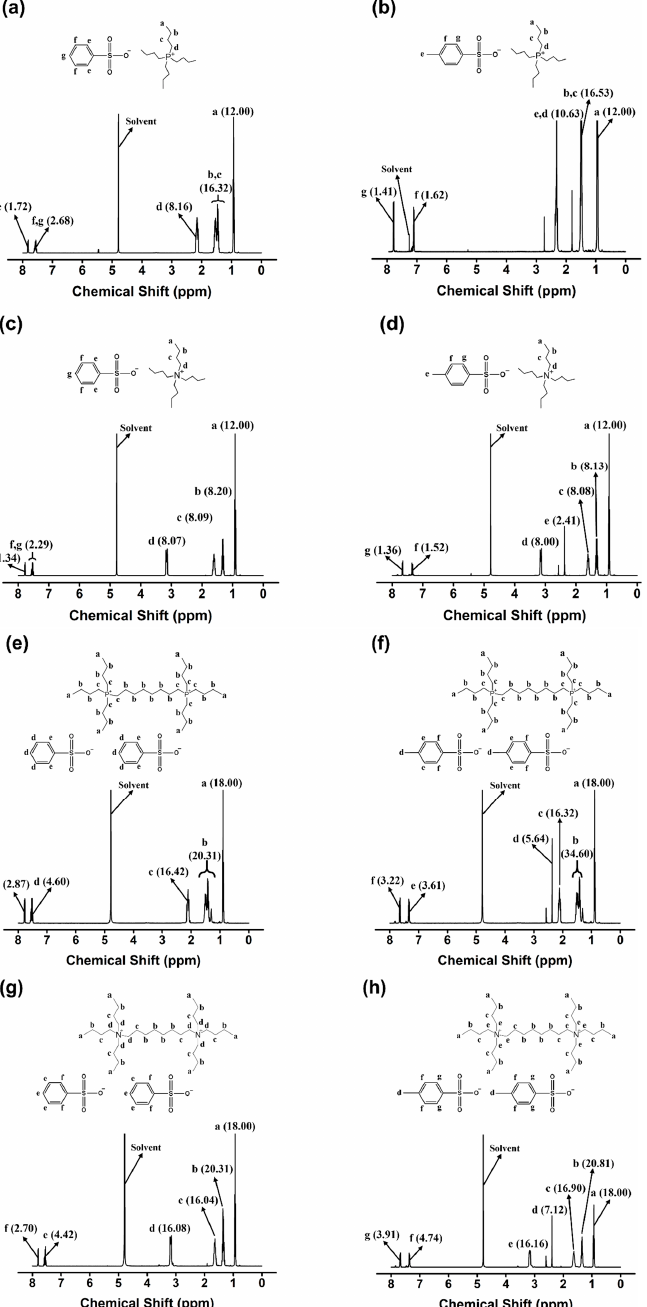
Figure 3. Proton nuclear magnetic resonance ( 1 H NMR) spectrum of ( a ) [P 4444 ][BS], ( b ) [P 4444 ][MBS], ( c ) [N 4444 ][BS], ( d ) [N 4444 ][MBS], ( e ) [(P 4444 ) 2 ][BS], ( f ) [(P 4444 ) 2 ][MBS], ( g ) [(N 4444 ) 2 ][BS], and ( h ) [(N 4444 ) 2 ][MBS]. The 1 H-NMR spectra of the dicationic series are shown in Figure 3e–h. In Figure 3e, the spectrum of [(P 4444 ) 2 ][BS] contains peaks from the aromatic group of the benzenesulfonate moiety ( δ = 7.50 − 7.60 (peak d), 7.77 − 7.84 ppm (peak e)) and alkyl peaks in the tetrabutylphosphonium moiety ( δ = 0.89–0.99 (peak a), 1.30–1.64 (peak b), and 2.09– 2.22 (peak c)). The 1 H-NMR spectrum of [(P 4444 ) 2 ][MBS] contains additional peaks corresponding to the added methyl protons when compared to the spectrum of [(P 4444 ) 2 ][BS]: δ = 2.33 − 2.43 (peak d, Figure 3f). In Figure 3g, the spectrum of [(N 4444 ) 2 ][BS] contains peaks from the aromatic group of the benzenesulfonate moiety ( δ = 7.78 − 7.83 (peak e), 7.52 − 7.63 ppm (peak f)) and the tetrabutylammonium moiety ( δ = 0.83–1.00 (peak a), 1.19–1.41 (peak b), 1.54–1.71 (peak c), and 3.11–3.26 (peak d)). The 1 H-NMR spectrum of [(N 4444 ) 2 ][MBS] contains additional peaks corresponding to the added methyl protons when compared to the spectrum of [(N 4444 ) 2 ][BS]: δ = 2.36 − 2.43 (peak d, Figure 3h). In all the ILs, the integrated area of each region matches the predicted proportion of hydrogen